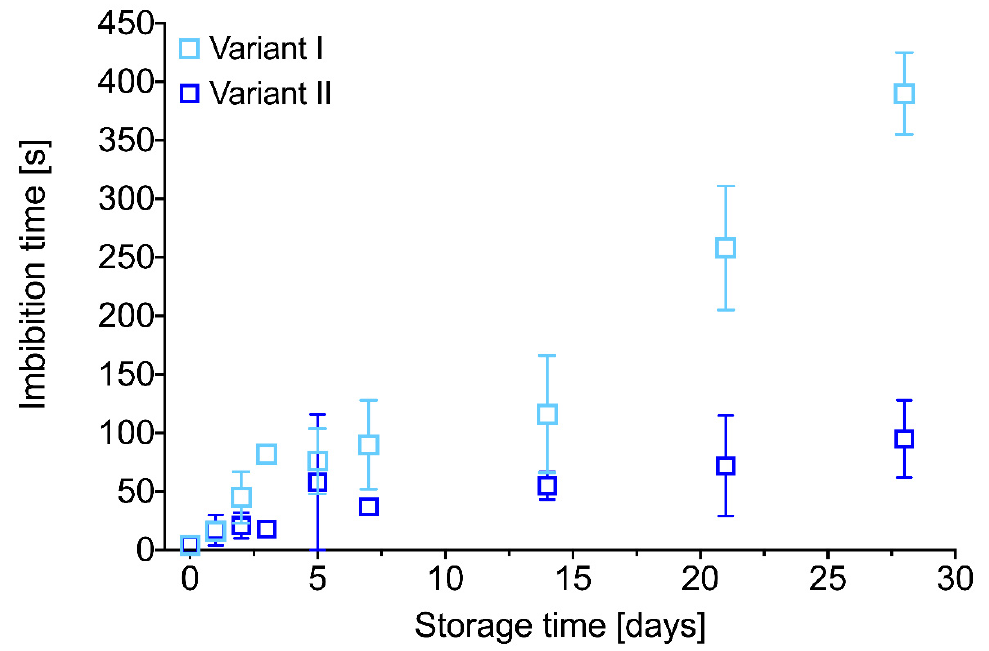
Figure 8. Stability of the hydrophilic property of PDA-modified PU nanofibrous materials (V-I, 8 h of